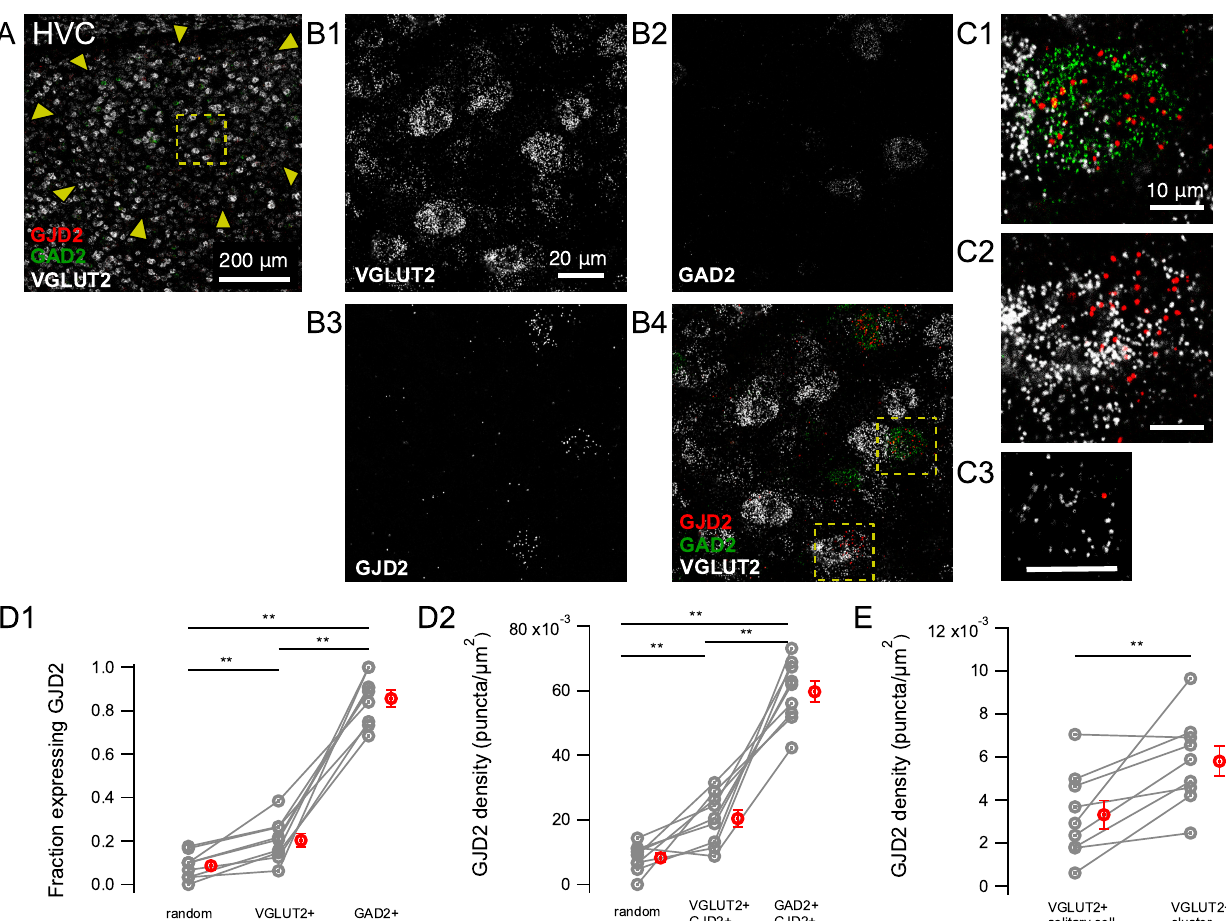
Figure 4. Expression of GJD2 mRNA in nucleus HVC from canaries. GJD2 mRNA is highly expressed in GAD2 mRNA- positive neurons and in only a fraction of excitatory cells coexpressing VGLUT2 mRNA. ( A ) HVC nucleus overview. ( B1 – B4 ) Magnification from the region highlighted in A. ( C1 , C2 ) insets show magnifications from regions highlighted in B4 of a GAD2 mRNA-positive, GJD2 mRNA-positive cell and a VGLUT2 mRNA-positive, GJD2 mRNA-positive cell cluster. ( C3 ) GJD2 expression in a solitary excitatory cell. Scale bars in C1-C3, 10 µ m. ( D1 ) fraction of cells expressing GJD2 within each population of labeled neurons: VGLUT2 mRNA-positive and GAD2 mRNA-positive cells. ‘Random’, randomly drawn ROIs which did not contain DAPI staining and which were neither stained for DAPI nor for VGLUT2/GAD2. ( D2 ) density of GJD2 mRNA puncta among VGLUT2 mRNA-positive and GAD2 mRNA-positive cells expressing GJD2 mRNA. ( E ) Comparison of the average GJD2 mRNA density in solitary cells and in cell clusters, defined as groups of cells formed by two or more adjacent cells. ** P < 0.01, two-tailed Wilcoxon signed-rank test. Each gray symbol represents the average for one animal. The average values of the same animal for the three types of ROI are linked together. Red symbols, average across animals. Error bars: ± S.E.M. In HVC, the fraction of GJD2 mRNA-positive cells was 20.3 ± 3.1% among